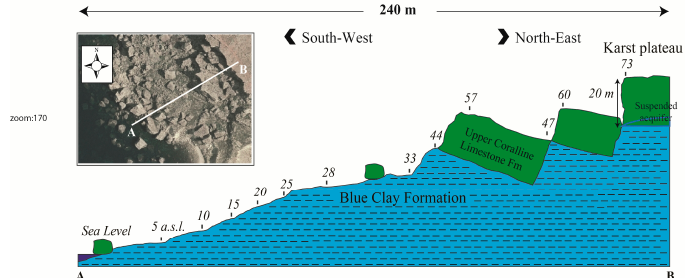
Figure 13. SW-NE geological section of Ras Il-Wahx site (Figure 12) showing block slides phenomena.